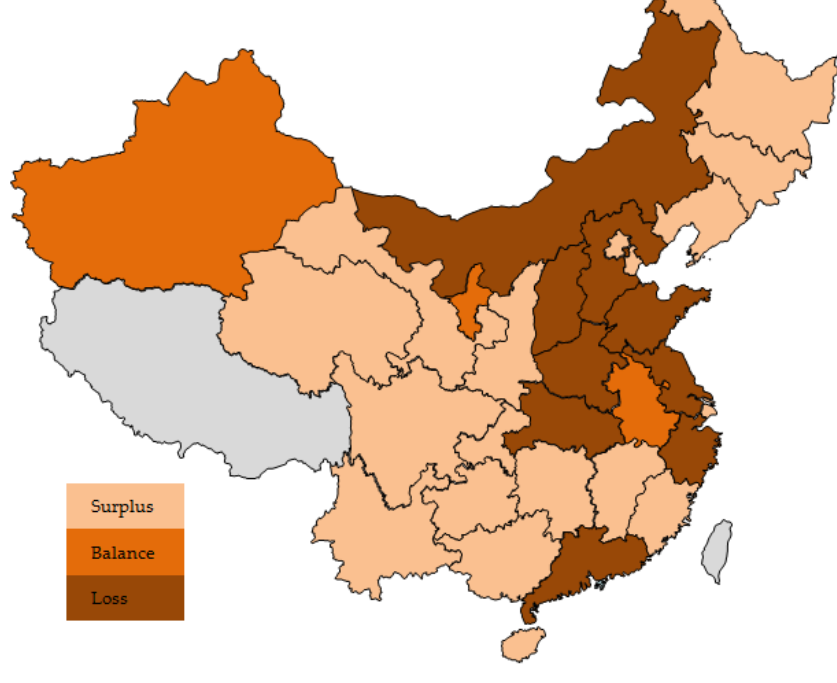
Figure 5. Geographical distribution of carbon quota remainder.